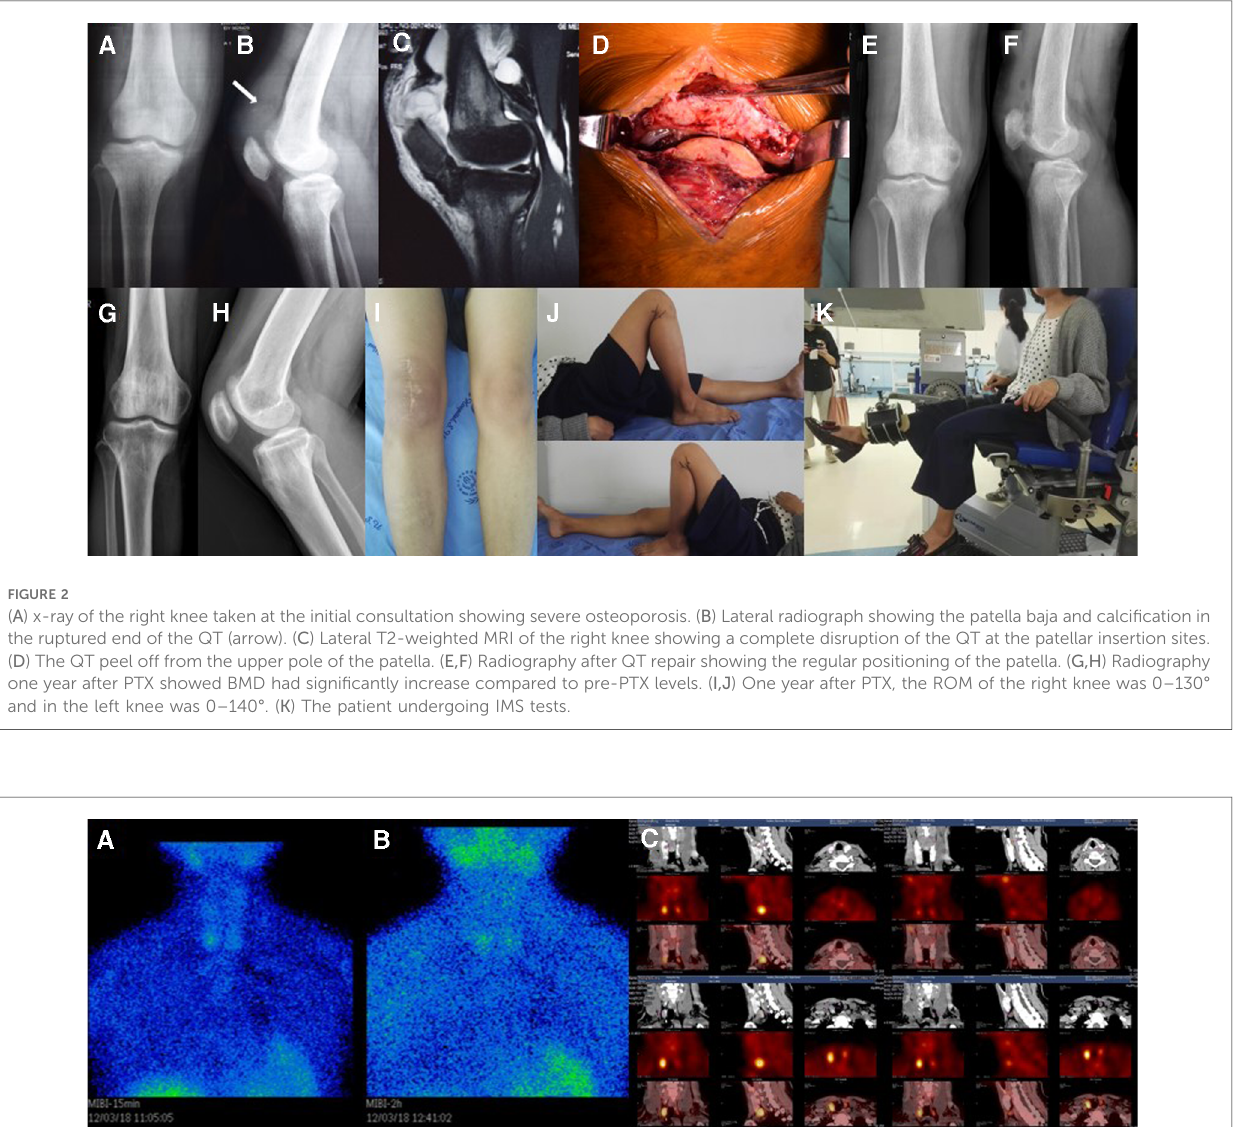
QT in patients with uremia and SHPT, PTX may promote tendon- bone healing.